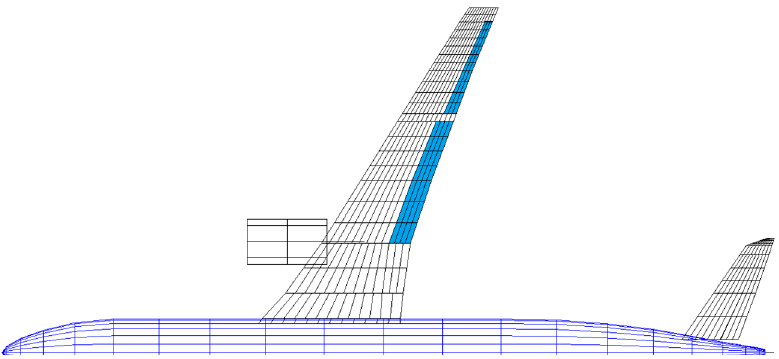
Figure 29. Deflected control surfaces using the enhanced MLA algorithm.